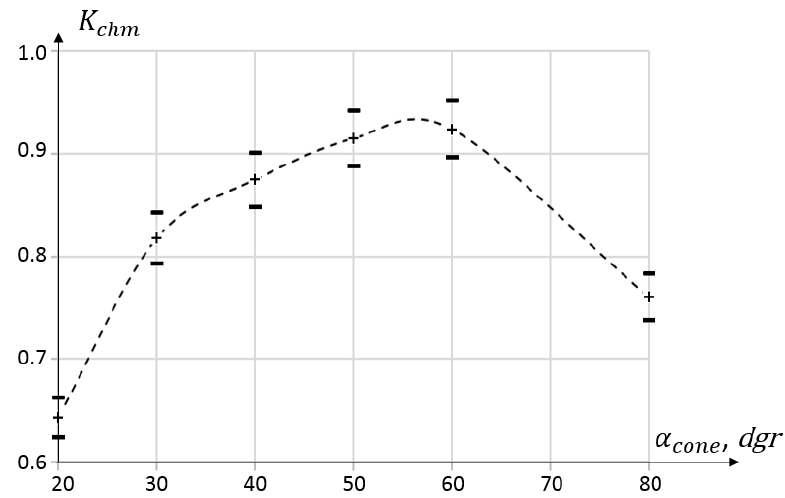
Figure 9. Homogeneity coe ffi cient of foam concrete mixture vs. inclination angle α cone of the conical Figure 9. Homogeneity coefficient of foam concrete mixture vs. inclination angle 𝛼 (cid:3030)(cid:3042)(cid:3041)(cid:3032) of the conical part of turbulent mixer at fixed mixing time t = 180 s (experimental Figure 9. Homogeneity coefficient of foam concrete mixture vs. inclination angle 𝛼 (cid:3030)(cid:3042)(cid:3041)(cid:3032) of the conical part of turbulent mixer at fixed mixing time t = 180 s (experimental data). part of turbulent mixer at fixed mixing time t = 180 s (experimental data).